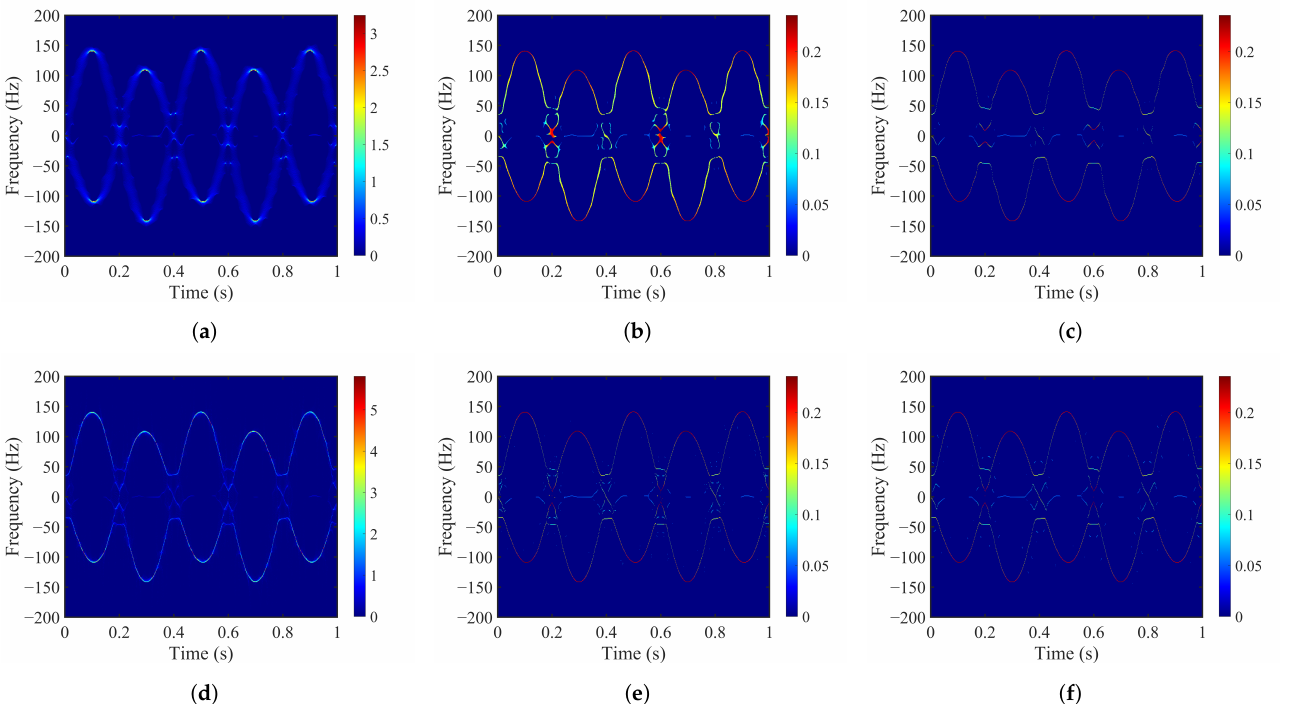
Figure 5. Micro-Doppler spectrum through different time–frequency analysis methods. ( a ) SST. ( b ) SET. ( c ) SRT. ( d ) SST2. ( e ) SET2. ( f )